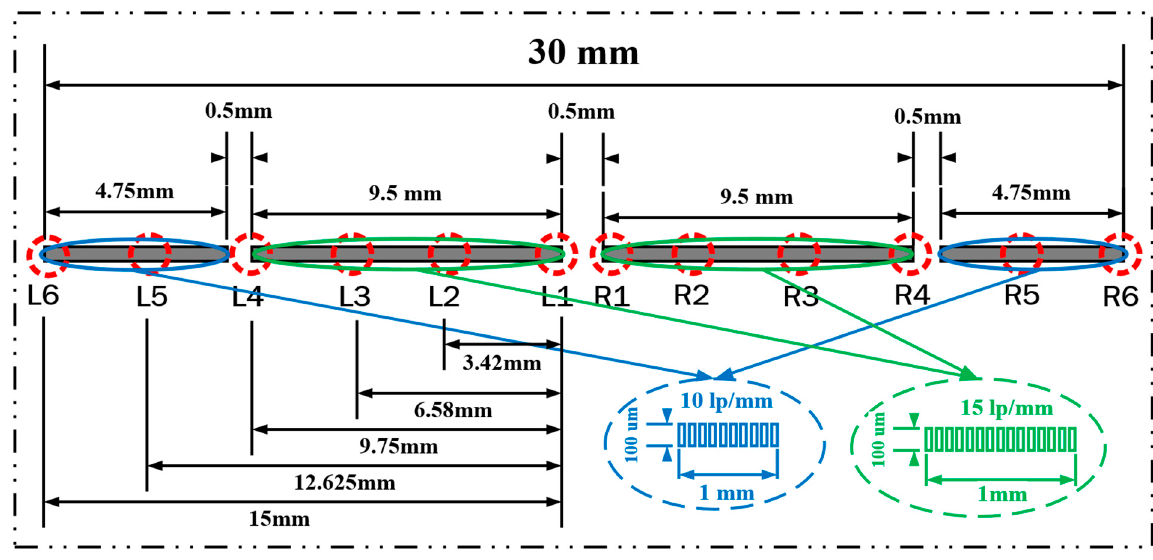
Figure 5. Schematic of experimental test points. Table 2. Data of different tube length with planar screen.